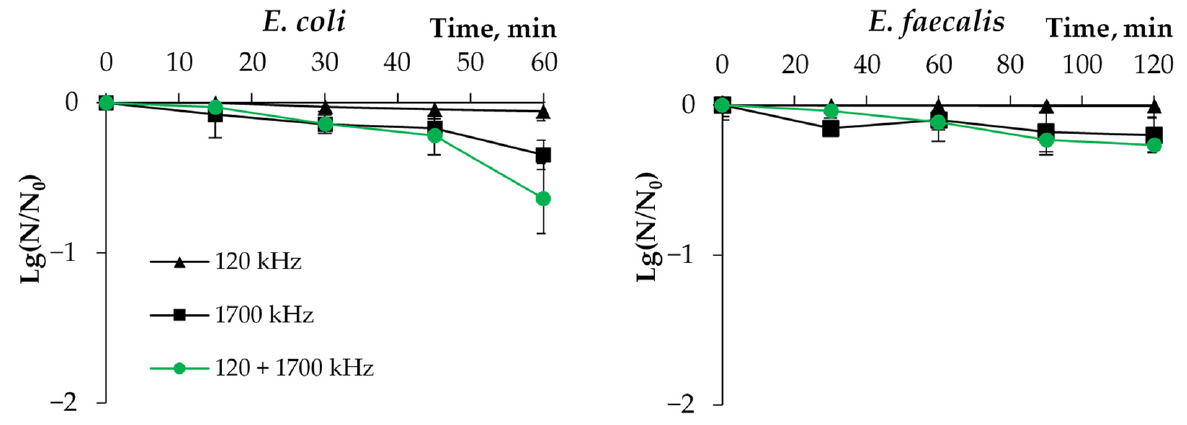
Figure 2. Inactivation of E. coli and E. faecalis by single- and dual-frequency ultrasound. Error bars represent ±SD.